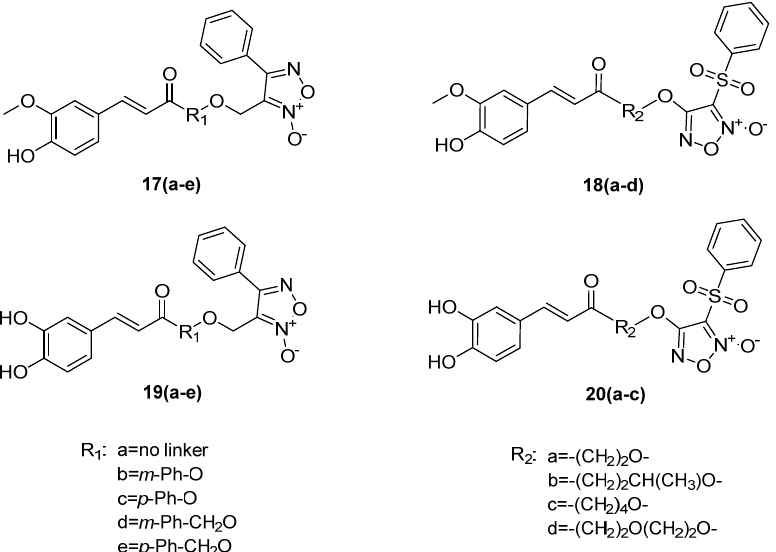
Figure 7. Chemical structure of the furoxan–cinnamic acid hybrids 17 – 20 with anti-atherosclerotic and anticancer activities [36,37].